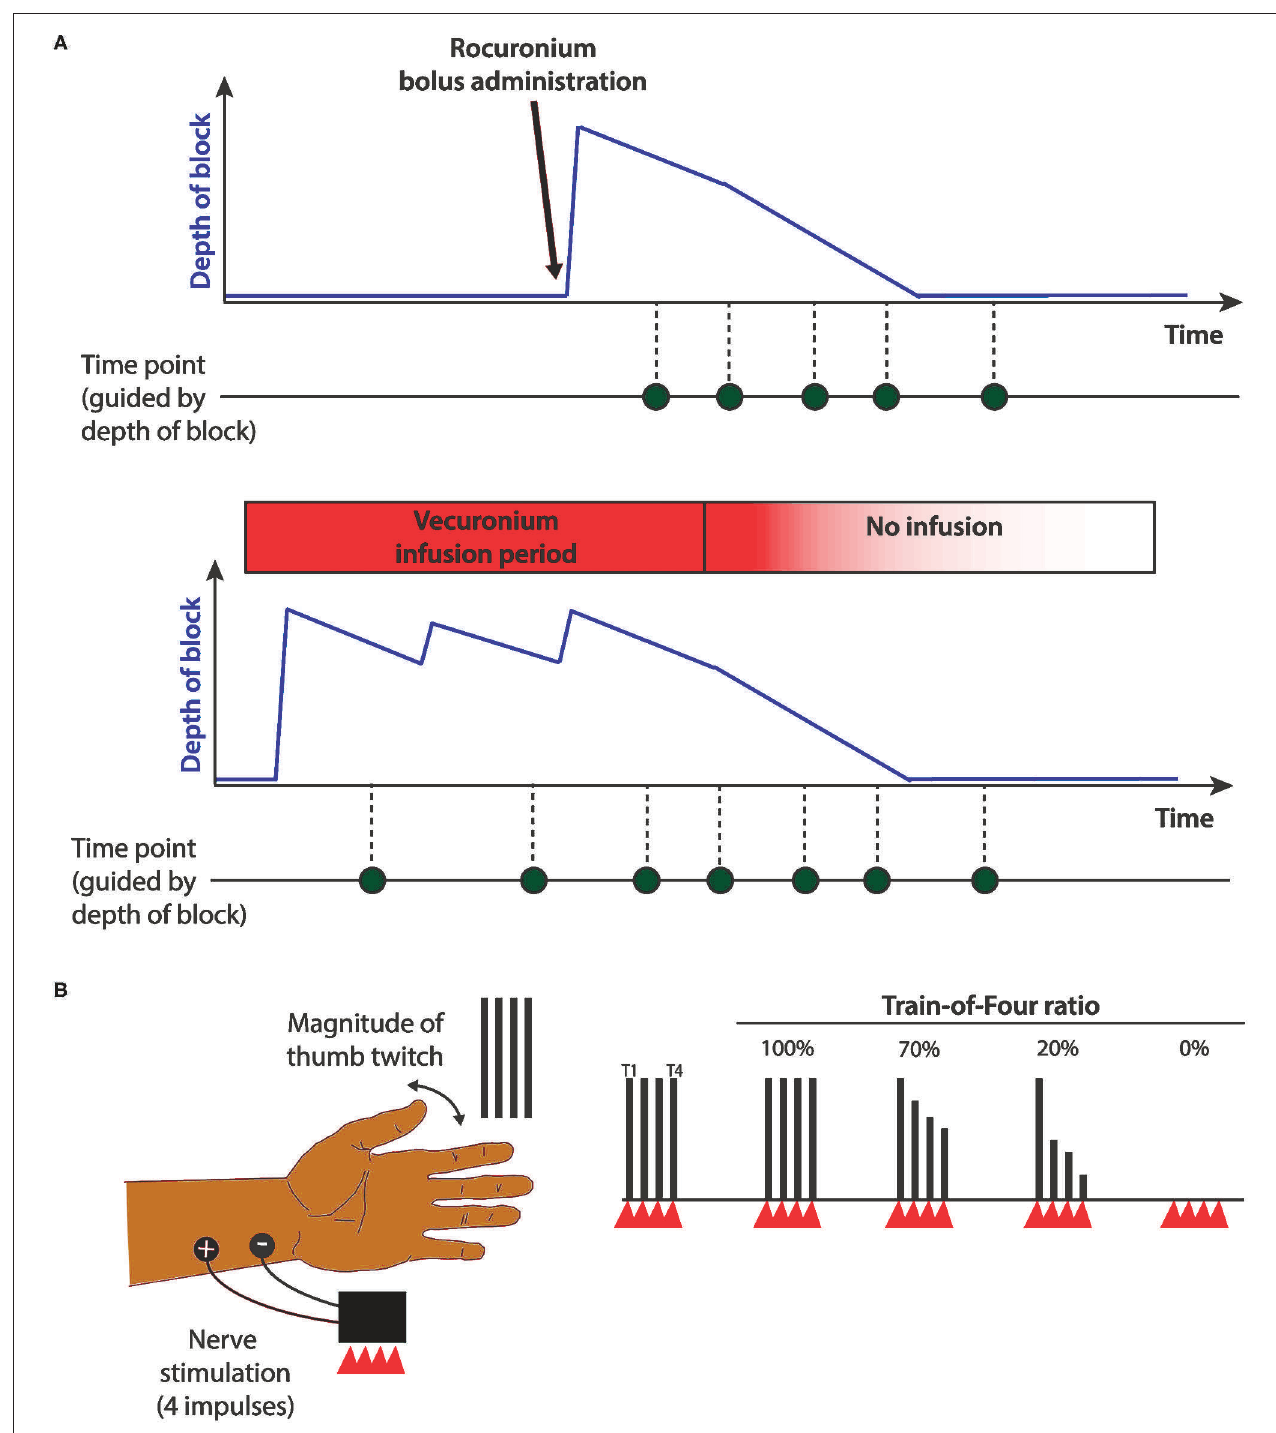
FIGURE 1 | Study protocol. (A) Schematic of study timeline for rocuronium bolus (upper panel) and continuous vecuronium infusion (lower panel). Blue line provides estimate of depth of block. Green dots indicate potential data collection time-point. (B) Train-of-Four assessment using ulnar nerve stimulation. Red triangles indicate train of four electrical stimuli; black vertical lines indicate degree of stimulus-evoked thumb twitch. T1, first stimulus; T4, fourth stimulus; Train-of-four ratio, T1/T4. 100% indicates complete nerve block whereas 0% indicates complete neuromuscular recovery. Adapted from (11).